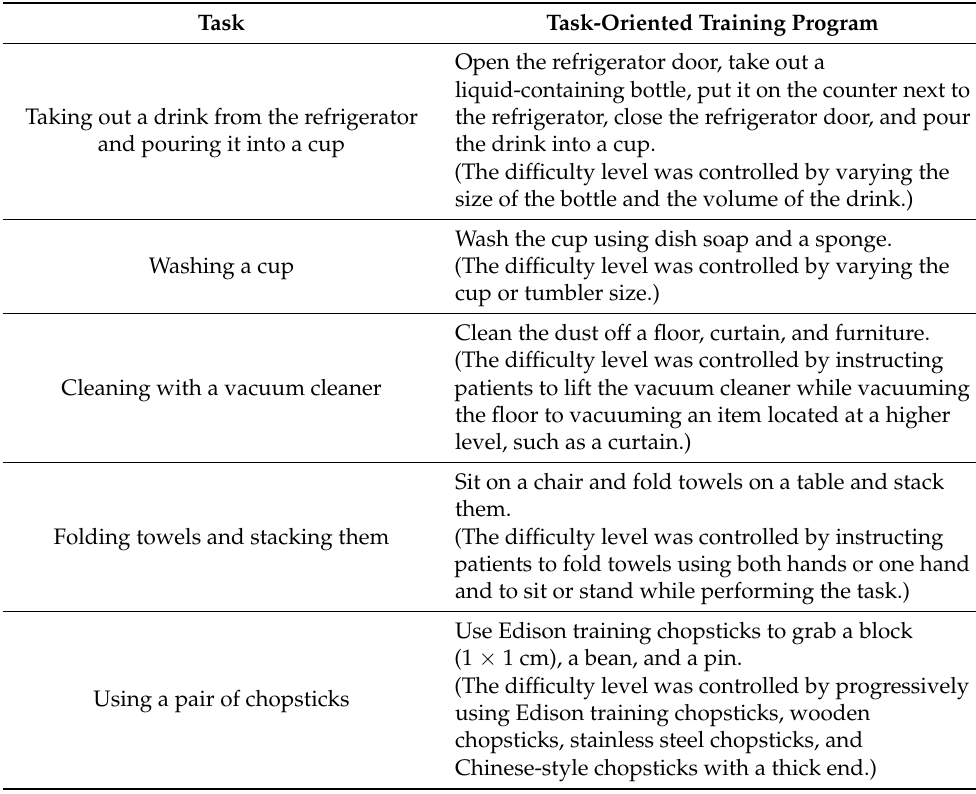
Table 1. Task-oriented movement therapy program.